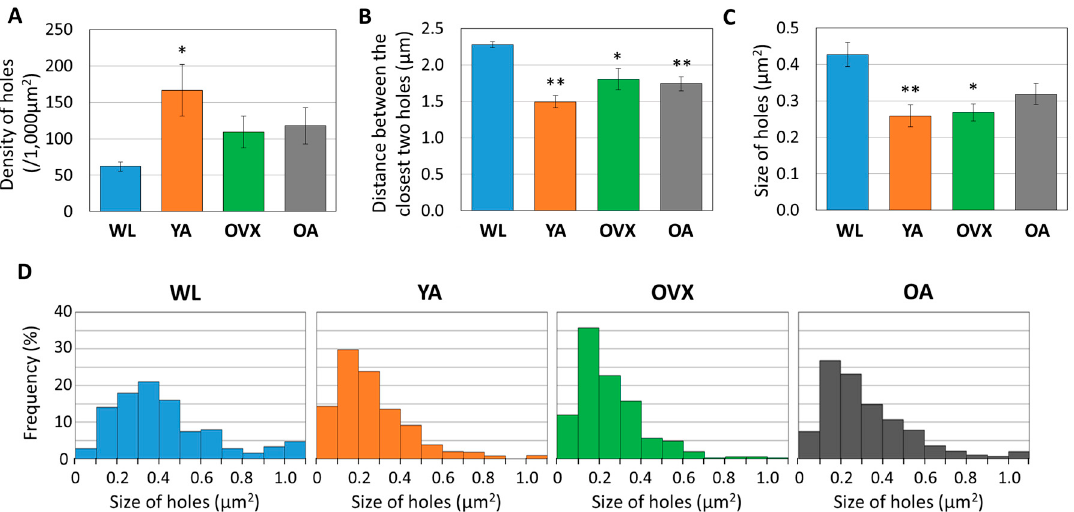
Figure 3. Histograms measuring ( A ) density, ( B ) distance between the closest two holes, and ( C ) size of 361 to 696 holes from three different individuals in each group. Values indicate the means ± standard error (S.E.). Significant differences between the WL group are indicated by *, p < 0.05 and **, p < 0.01. ( D ) Graph showing the distribution of hole sizes as proportions in four different models. In total, 361 to 696 of the holes are plotted according to their size.